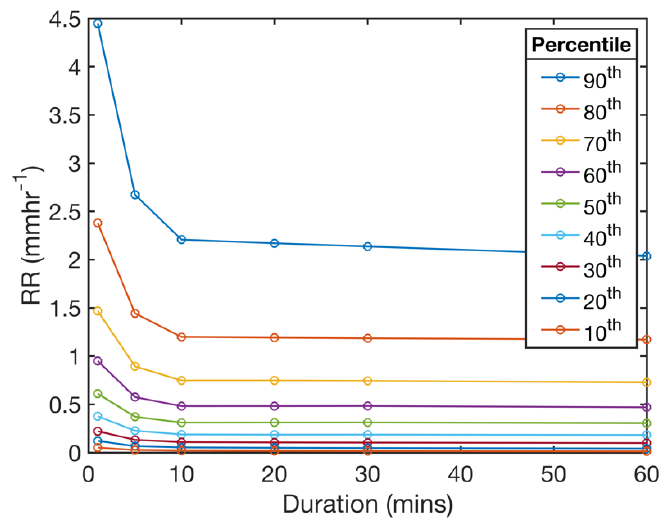
Figure 14. Rainfall rate (RR, in mmhr – 1 ) as a function of averaging period based on 4 years of 1 min data collected with the OTT Parsivel 2 disdrometer at the US SGP. Each 60 min time window when precipitation occurred is sampled to determine the maximum RR for averaging periods of 1, 5, 10, 20, 30 and 60 min. The results are presented as the 10th:10:90th percentile values for each averaging period.